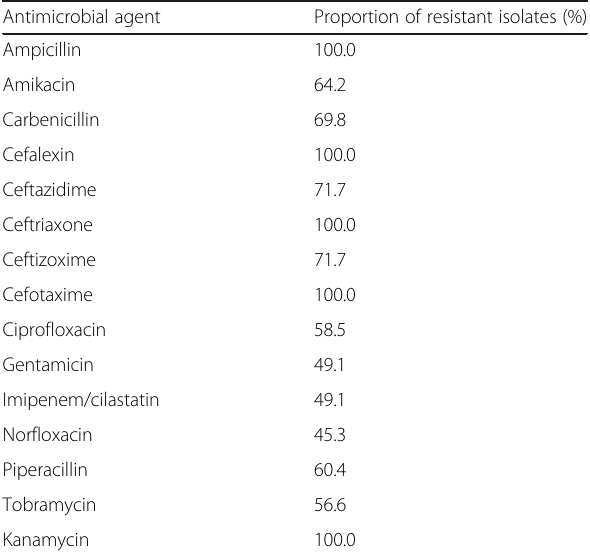
Table 3 Antimicrobial resistance profiles of P. aeruginosa isolates against 15 antimicrobial agents Antimicrobial